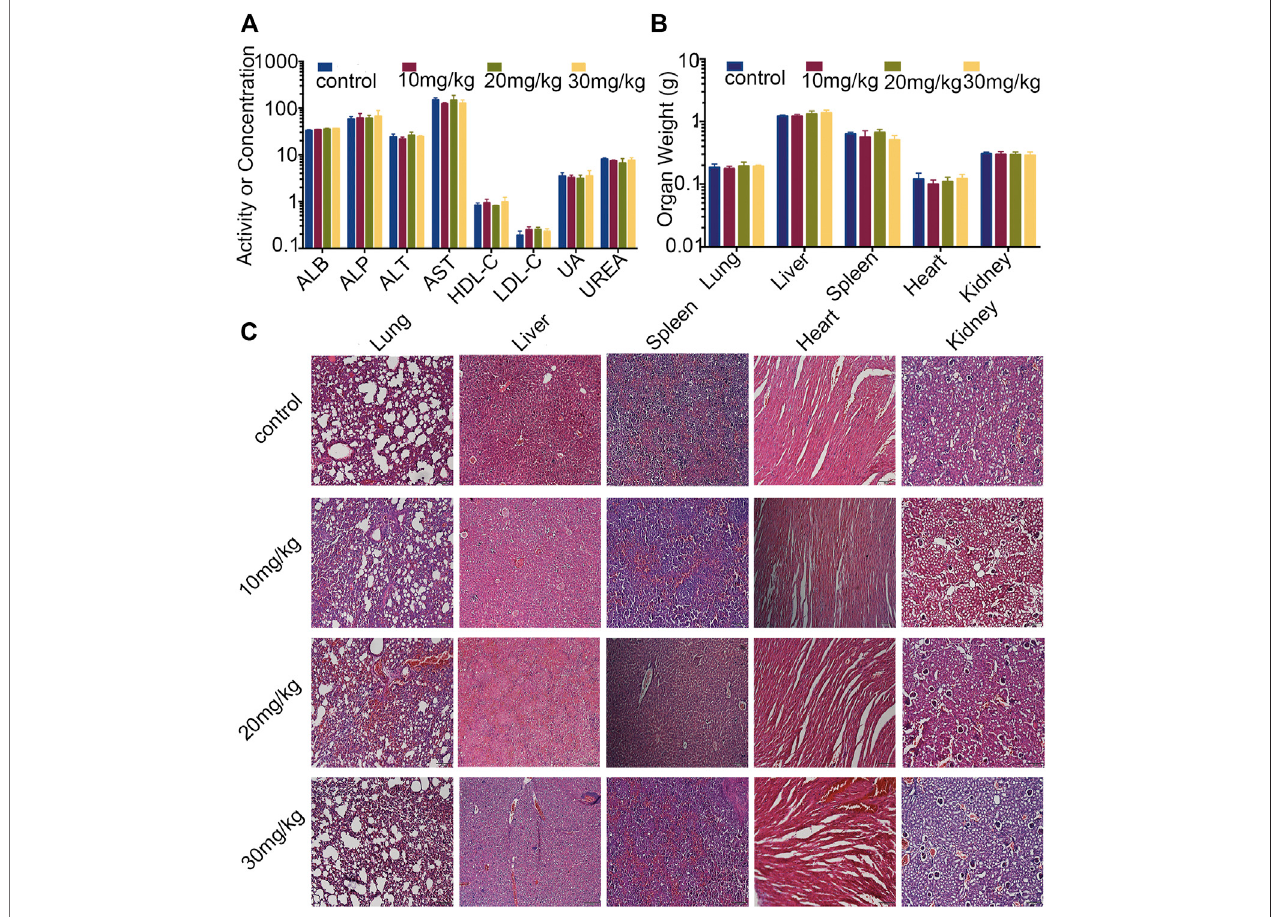
FIGURE 9 | Evaluation of side effects of Statmp-151 in mice. (A) Blood biochemical indexes of mice (ALB, ASP unite is g/L, ALT, AST unite is U/L, HDL-C, LDL-C, UREA unite is mmol/l, UA unite is mg/dl). (B) The weight of lung, liver, spleen, heart, and kidney. (C) Haematoxylin and eosin stained of paraf fi n sections of lung, liver, spleen, heart and kidney of mice treated with